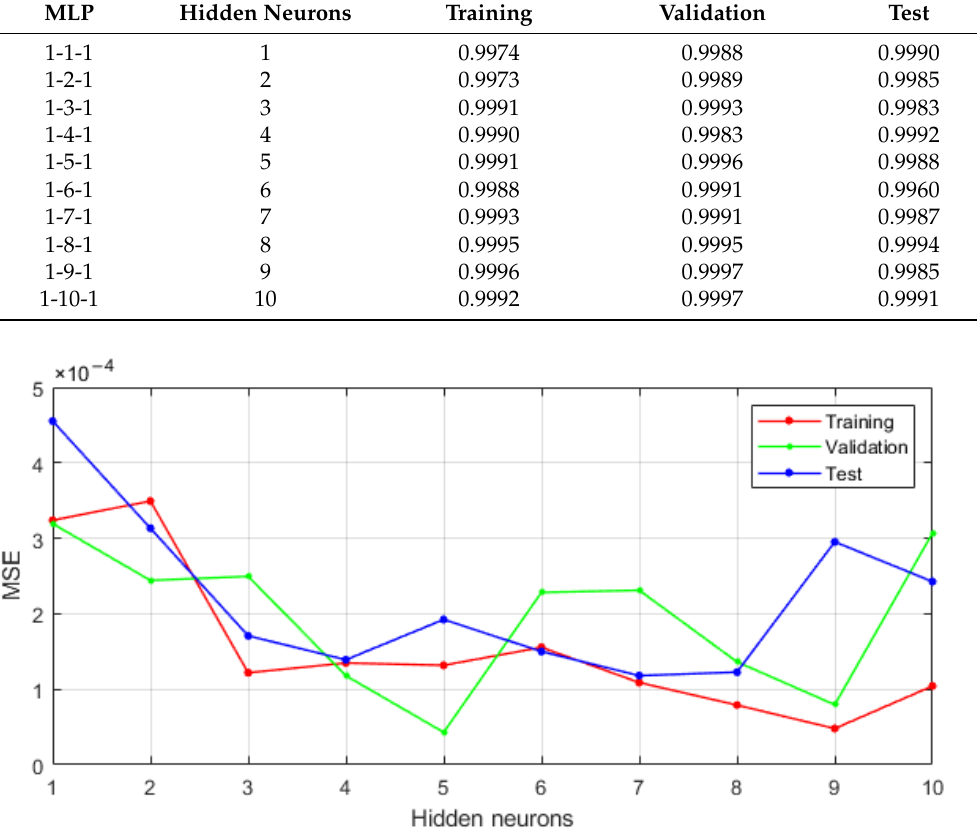
Figure 7. Sensitivity analysis of MSE error of neural model as a function of hidden neurons number.